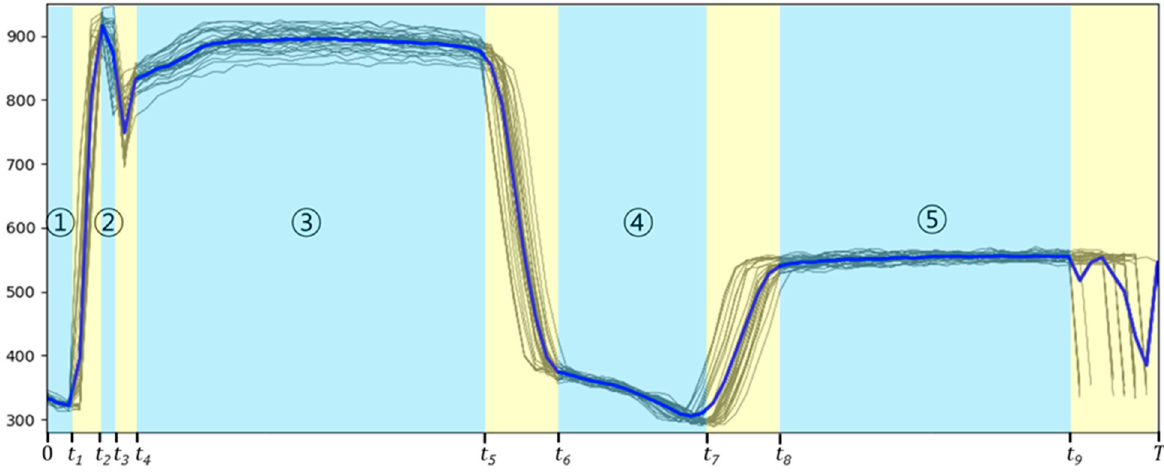
Figure 4. Example of signal segmentation.